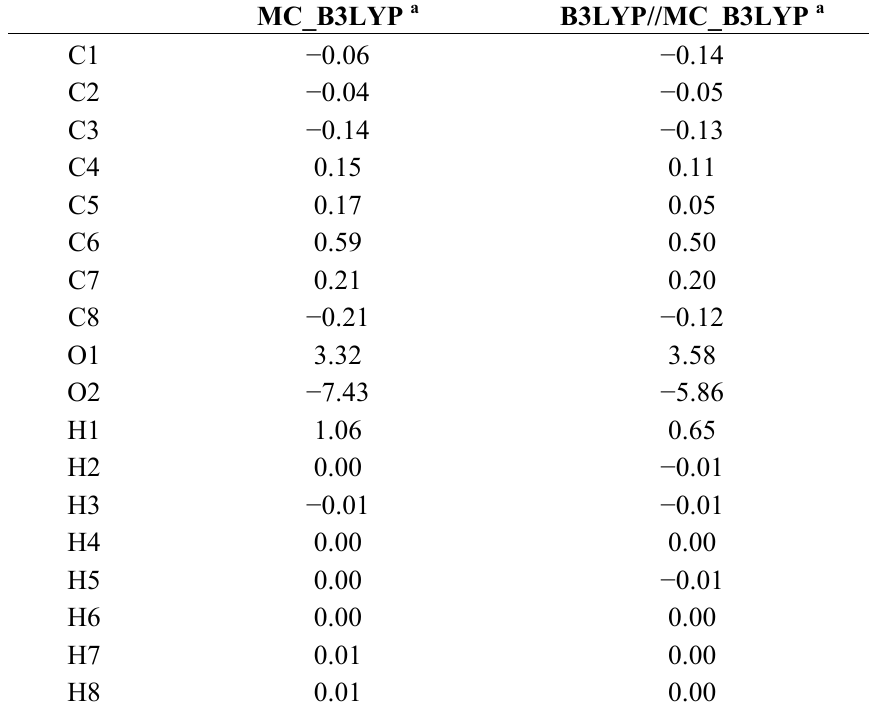
Table 5. Difference between the calculated nuclear magnetic shielding ∆σ (ppm) induced by H/D isotope effect on atoms in 1 .